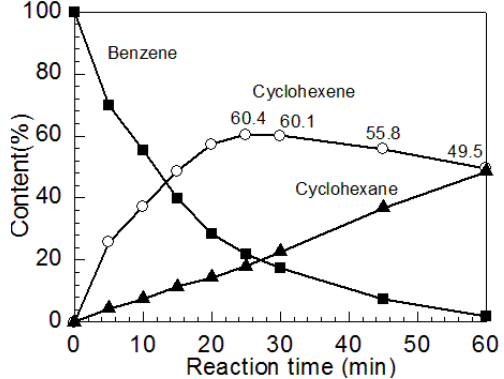
Figure 12. Reaction course of benzene hydrogenation over the Ru-4.7 catalyst under the optimized condition ( m cat = 2.0 g, m ZnO = 0.3 g, m ZnSO4 = 50.0 g, v H2O = 280 mL, v benzene = 140 mL, T = 423 K, p H2 = 5.0 MPa).